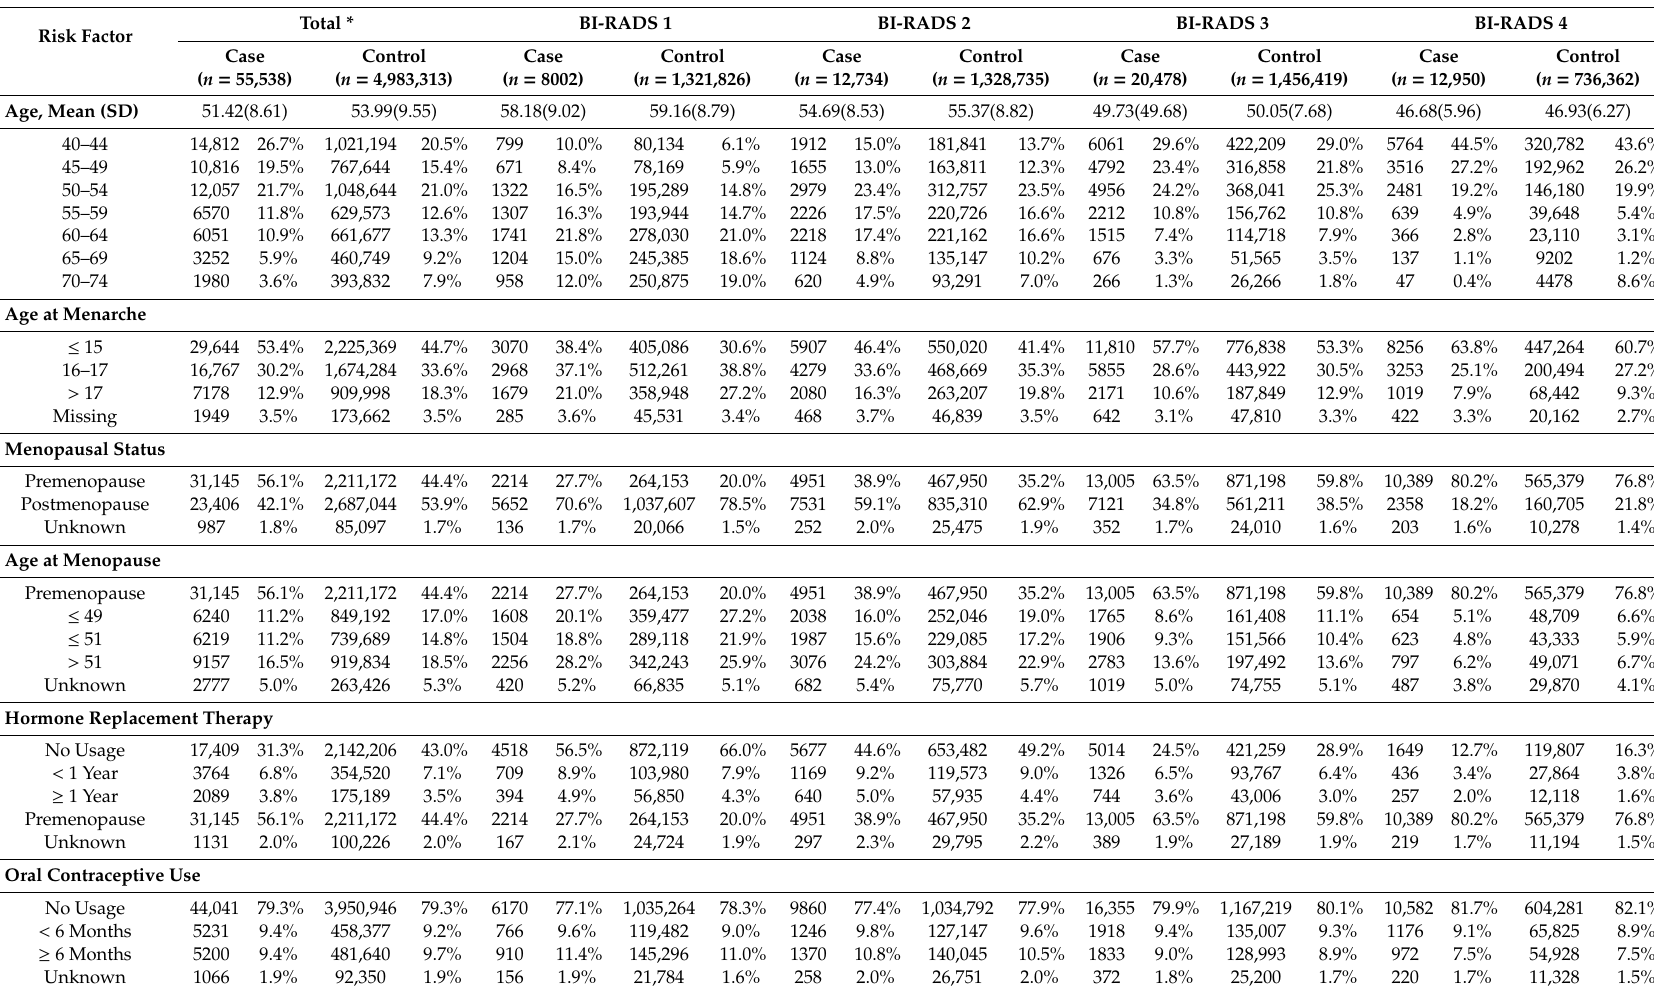
Table 1. Distribution of risk factors of breast cancer in subjects with or without incident breast cancer by mammographic